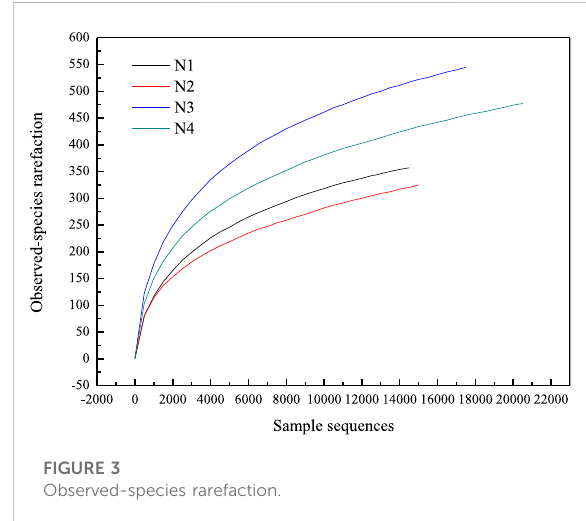
FIGURE 3 Observed-species